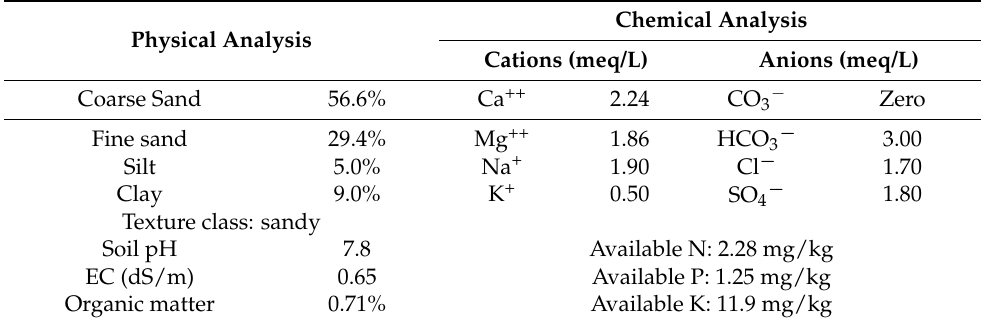
Table 7. Physical and chemical analysis results for the experimental